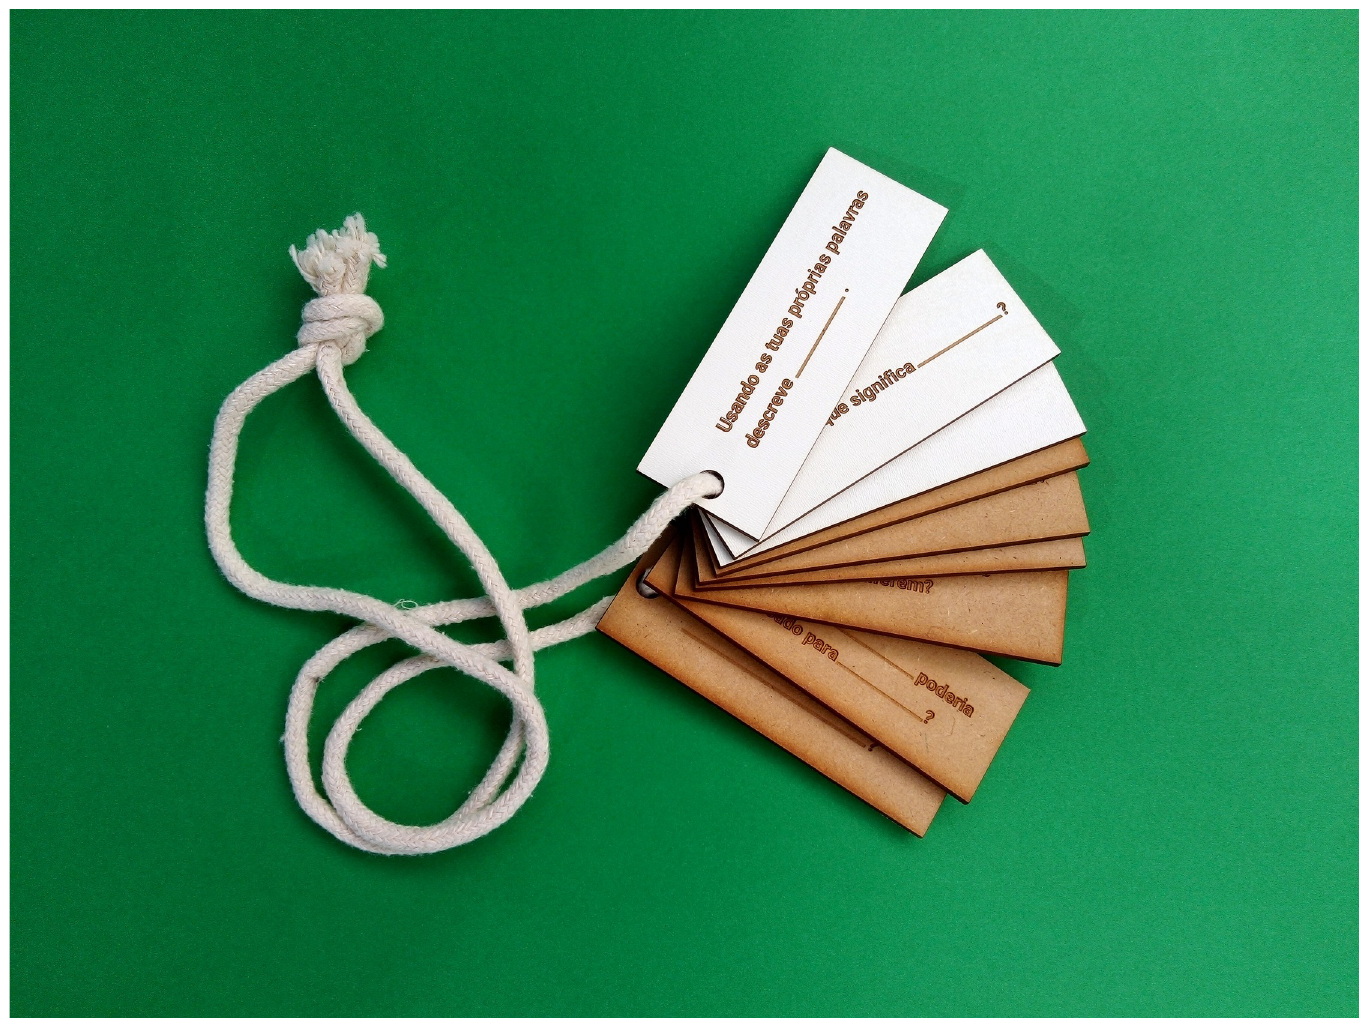
Fig 5. Question tokens (with questions in